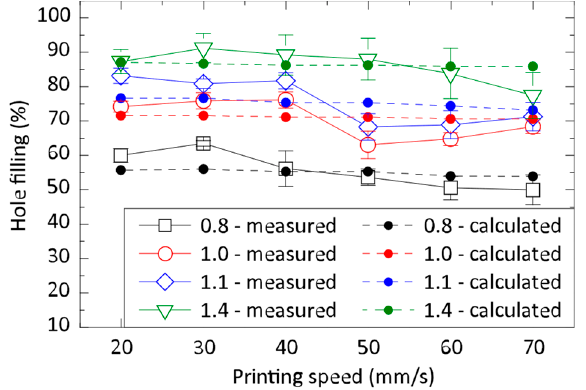
Figure 6. Empirical and calculated hole-filling by the solder paste; length of the holes in z -direction was 1.55 mm, and diameters were 0.8, 1.0, 1.1, 1.4 mm; average calculation error is 6%, and maximum calculation error is 12.8%.